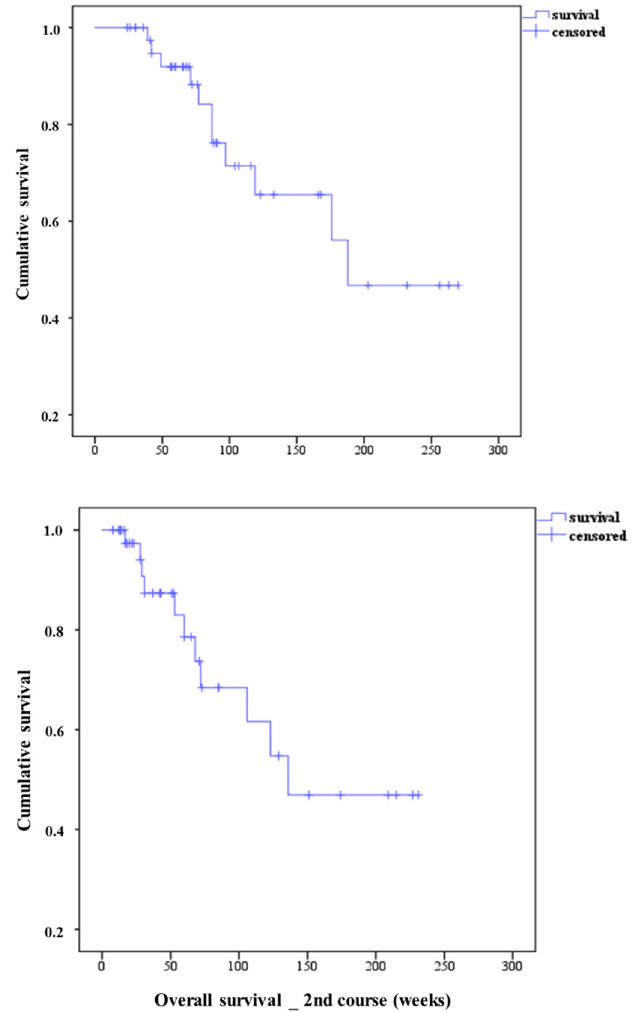
Figure 2. Kaplan–Meier plots of the treated patients received collectively two courses of PSMA-RLT, each course composed of three cycles of 7400 MBq PSMA-RLT every 4 weeks. The median overall survival from the time of the first cycle of the first PSMA-RTL course was 188 weeks, whereas the median survival from the time of the first cycle of the second PSMA-RLT course was 136 weeks. Table 4. Median overall survival and median progression-free survival in weeks calculated from the time of the first and second PSMA-RLT course in relation to the type of metastases present.